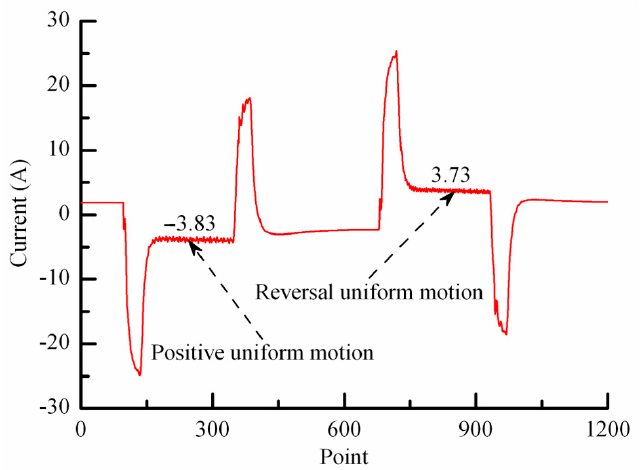
Figure 9. Electric current of the servo motor.